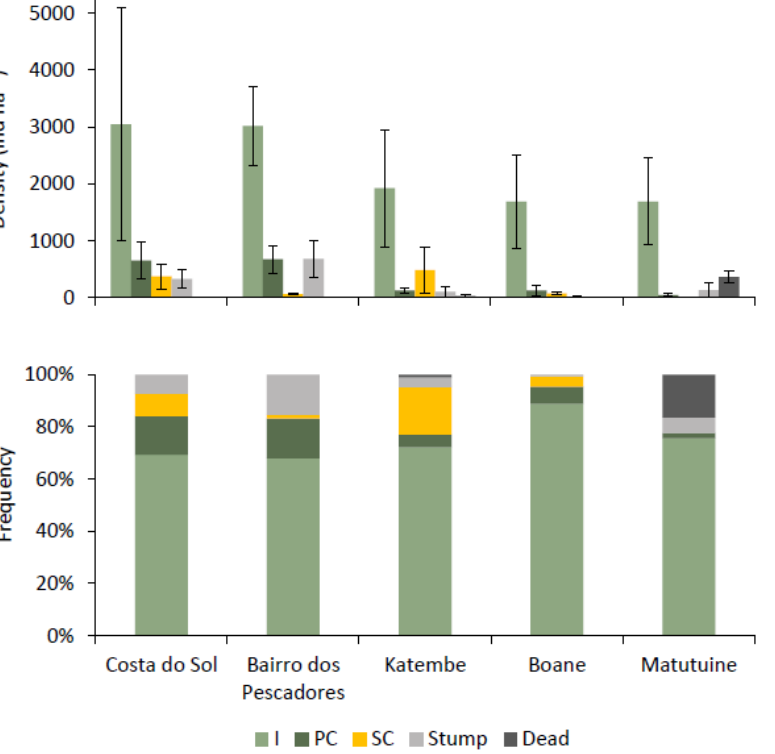
Figure 4. Density ( ± SE) and percentage of intact (I), partially cut (PC), severely cut (SC), stumps and dead trees, in Maputo Bay.